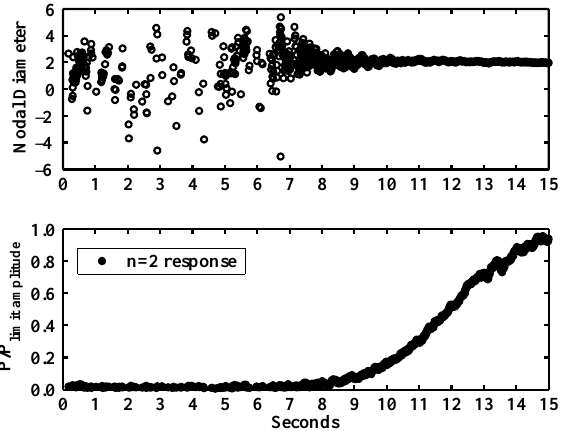
Fig. 7. Cross-power spectral analysis of pressure transducers 11 and 12 as the fan is back-pressured into flutter for n = 2 .